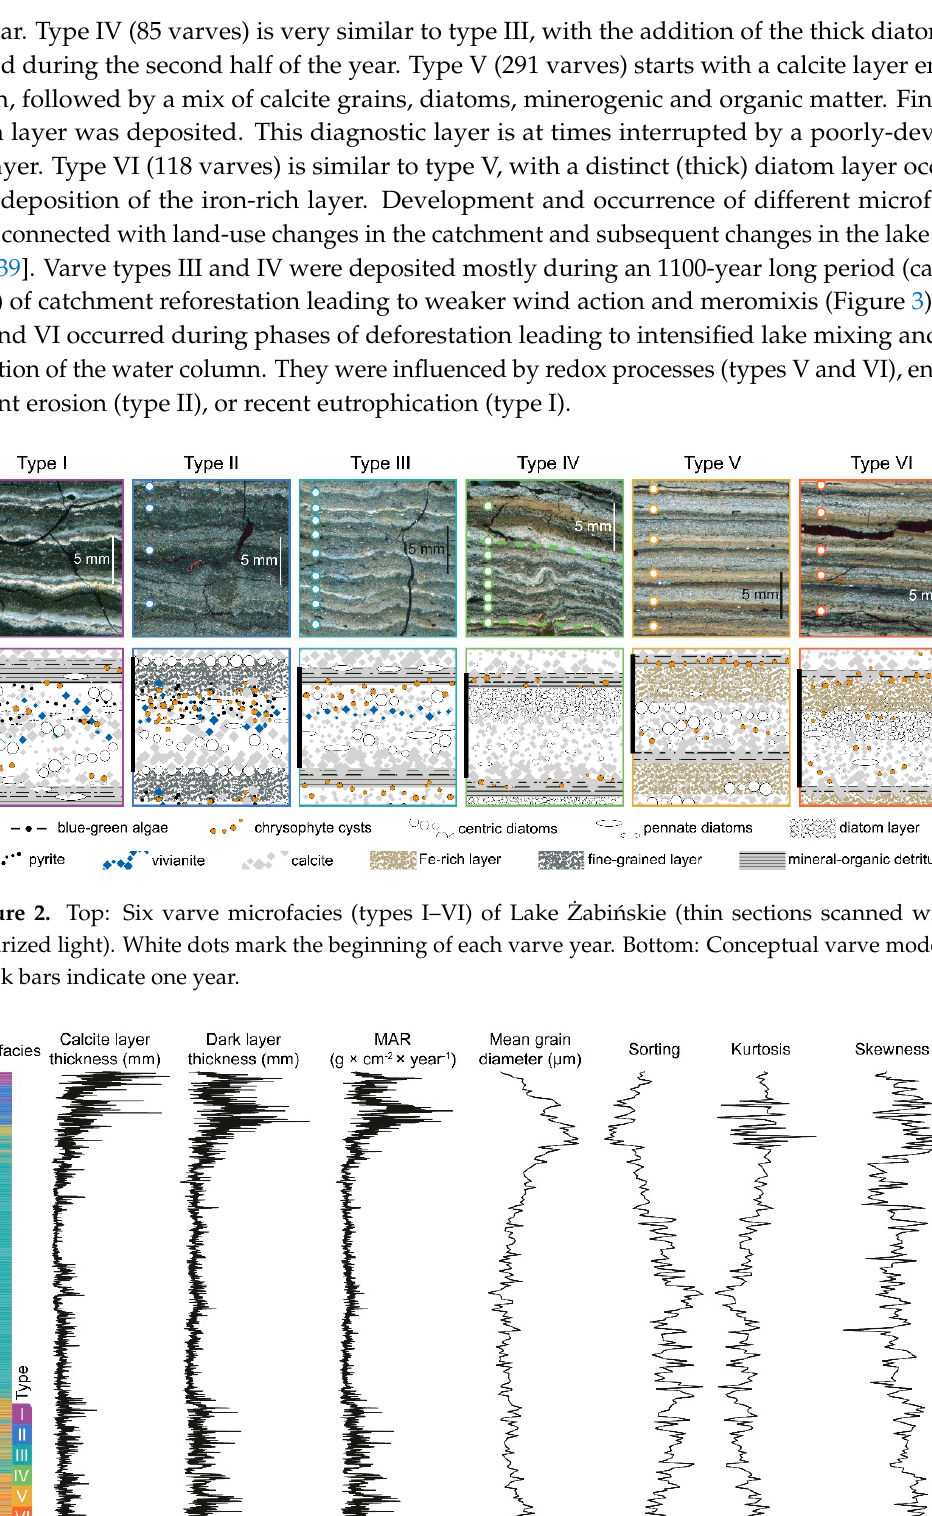
Figure 3. Varve microfacies with sedimentological, and grain-size variability plotted vs. time and depth.